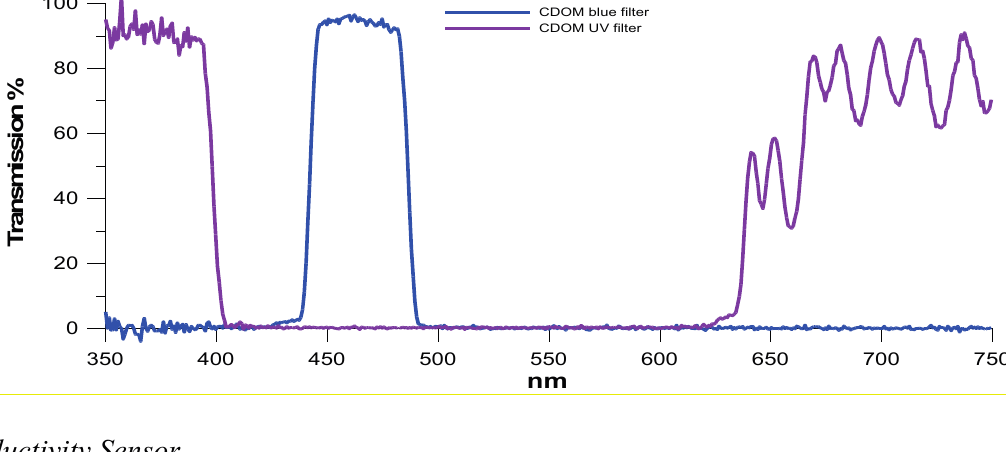
Figure 5. Transmission spectra of CDOM optical filters in the excitation ( Violet Curve ) and detection ( Blue Curve) modules obtained by an Ocean Optics QE65000 spectrometer.